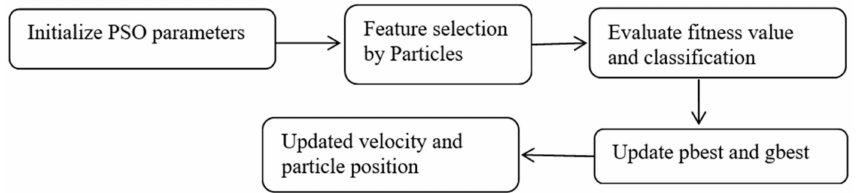
Figure 6. Feature selection by using